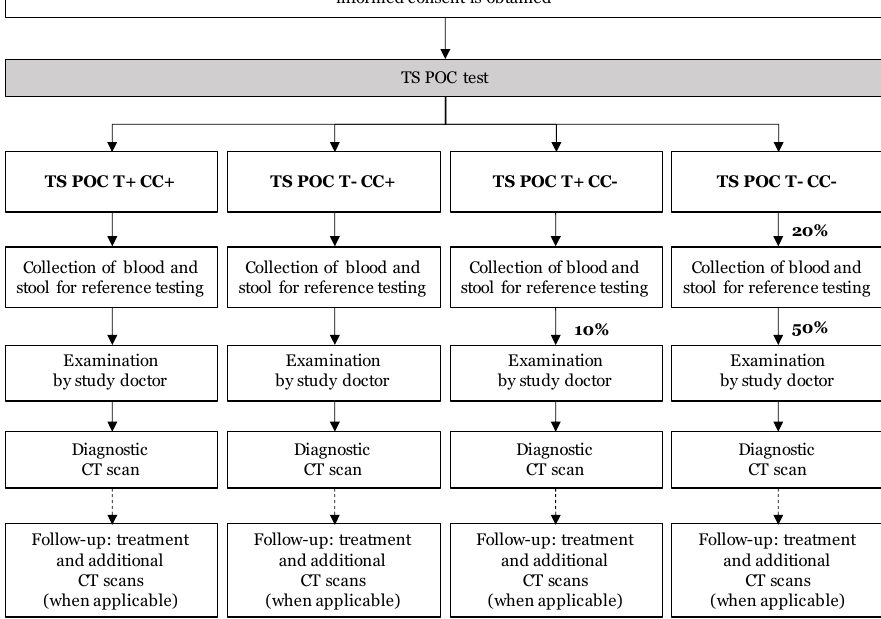
Table 1. Reference tests to assess the sensitivity and specificity of the TS POC test for different disease presentations of T. solium . Disease Presentation